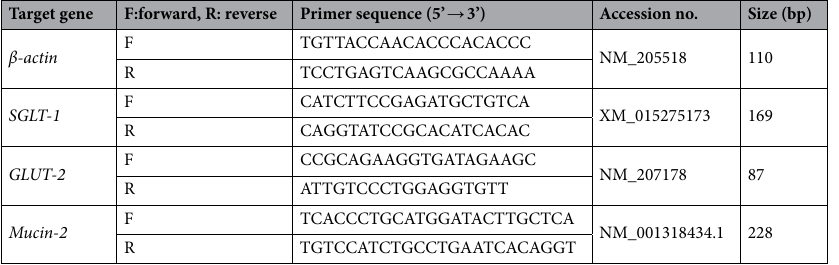
Table 2. Nucleotide sequence of primers for gene expression analysis. SGLT-1 : Na( +)-glucose cotransporter 1; GLUT-2 : Glucose transporter type 2.